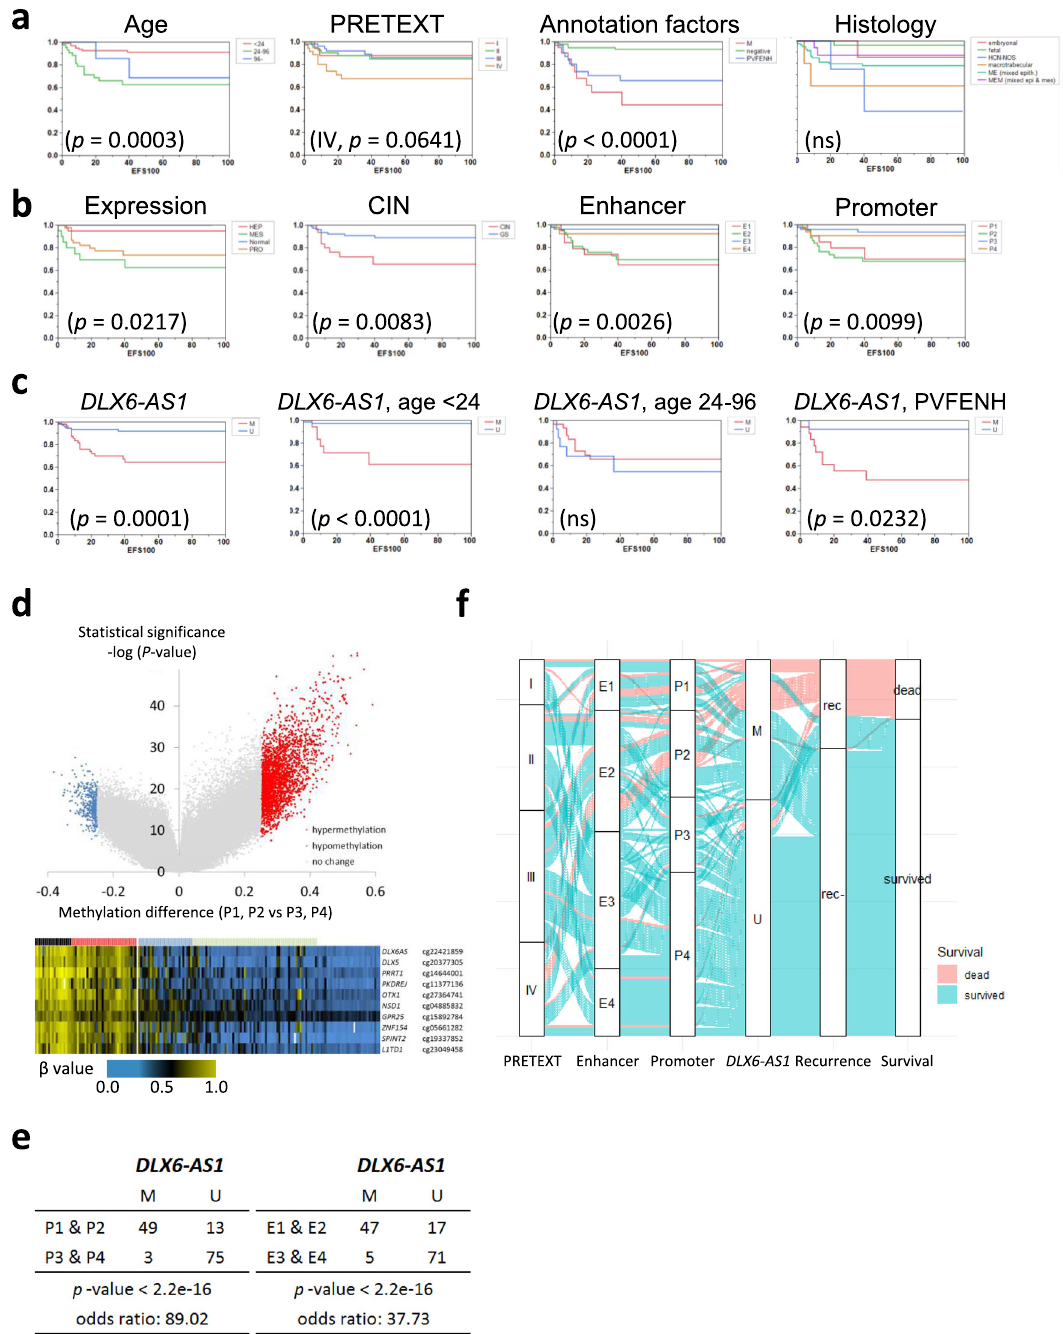
Fig. 7 Prognostic signi fi cance of clinical parameters and molecularly de fi ned subtypes. a , b Samples were strati fi ed according to the clinical parameters a and molecular-de fi ned subtypes b . a Age, age at diagnosis; PRETEXT, the PRETEXT staging system; Annotation factors (M distant metastasis, + positive for VPERFNH, − negative for the annotation factors); Histology histologic subtypes. b Expression, gene expression; CIN, chromosomal instability; Enhancer, enhancer methylation; Promoter, promoter methylation. Statistical signi fi cance was analyzed using the log-rank test. c Surrogate methylation marker DLX6- AS1 (cg22421859, chr7:96622043) for all childhood hepatoblastoma (HB) cases (left) and limited subgroup (middle, for infant HB; right, for AF-positive cases). d Volcano plots of differential methylation between older HB cases (P1, P2) and younger cases (P3, P4). The heat map in the bottom shows the methylation status of the 10 most signi fi cant CpG sites using the two-sided Fisher ’ s exact test. e Surrogate methylation, DLX6-AS1 to distinguish methylation subtypes. Statistical signi fi cance was analyzed using Fisher ’ s exact test. f Sankey diagram stratifying the HB cases with poor prognosis by DLX6-AS1